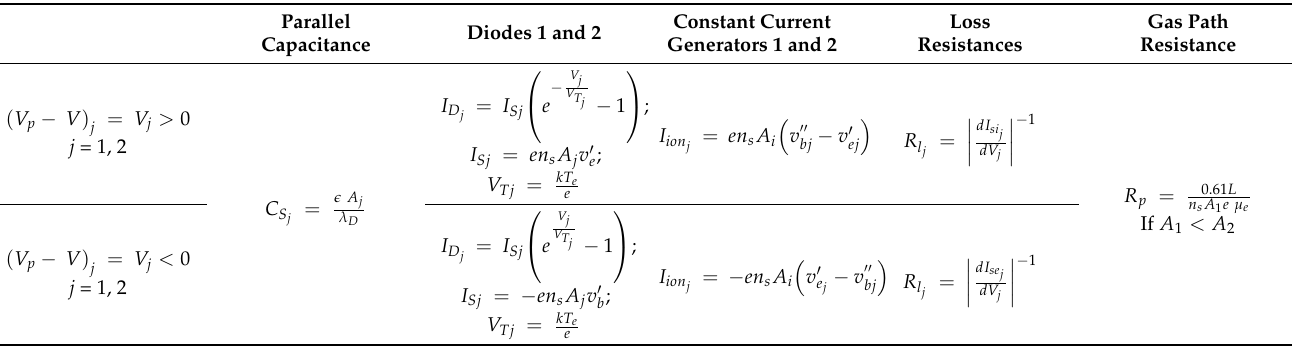
Table 1. Complete equivalent circuit parameter